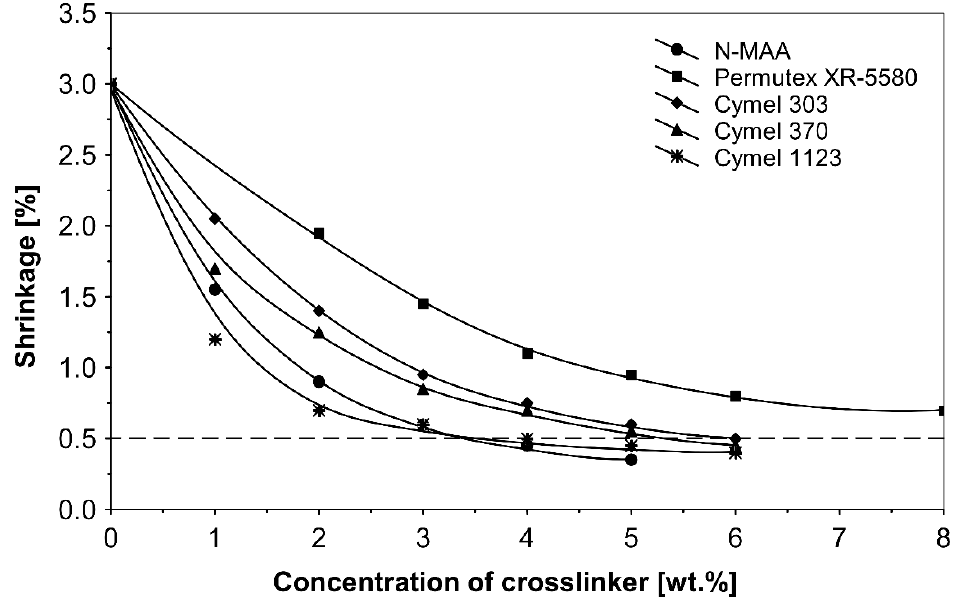
Figure 2. Shrinkage of the acrylic PSAs crosslinked using: N-MAA, Permutex XR-5580 and selected Cymel amino resins.